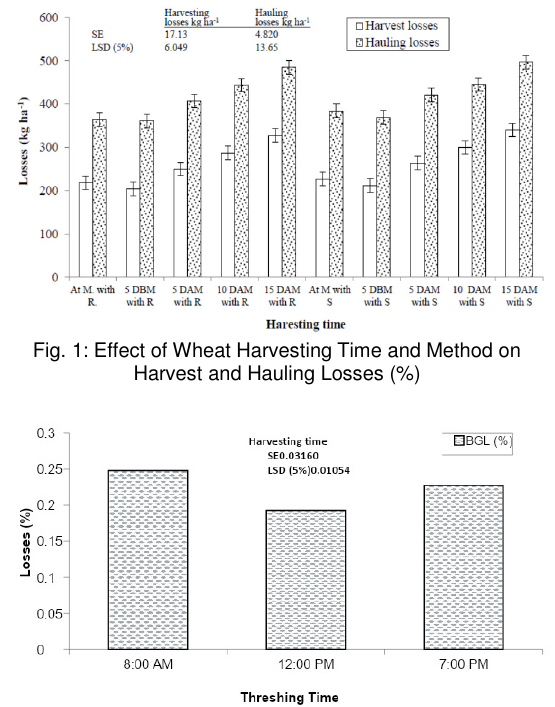
Fig. 2: Effect of Different Threshing Time on Broken Grain Losses in Weight (%)